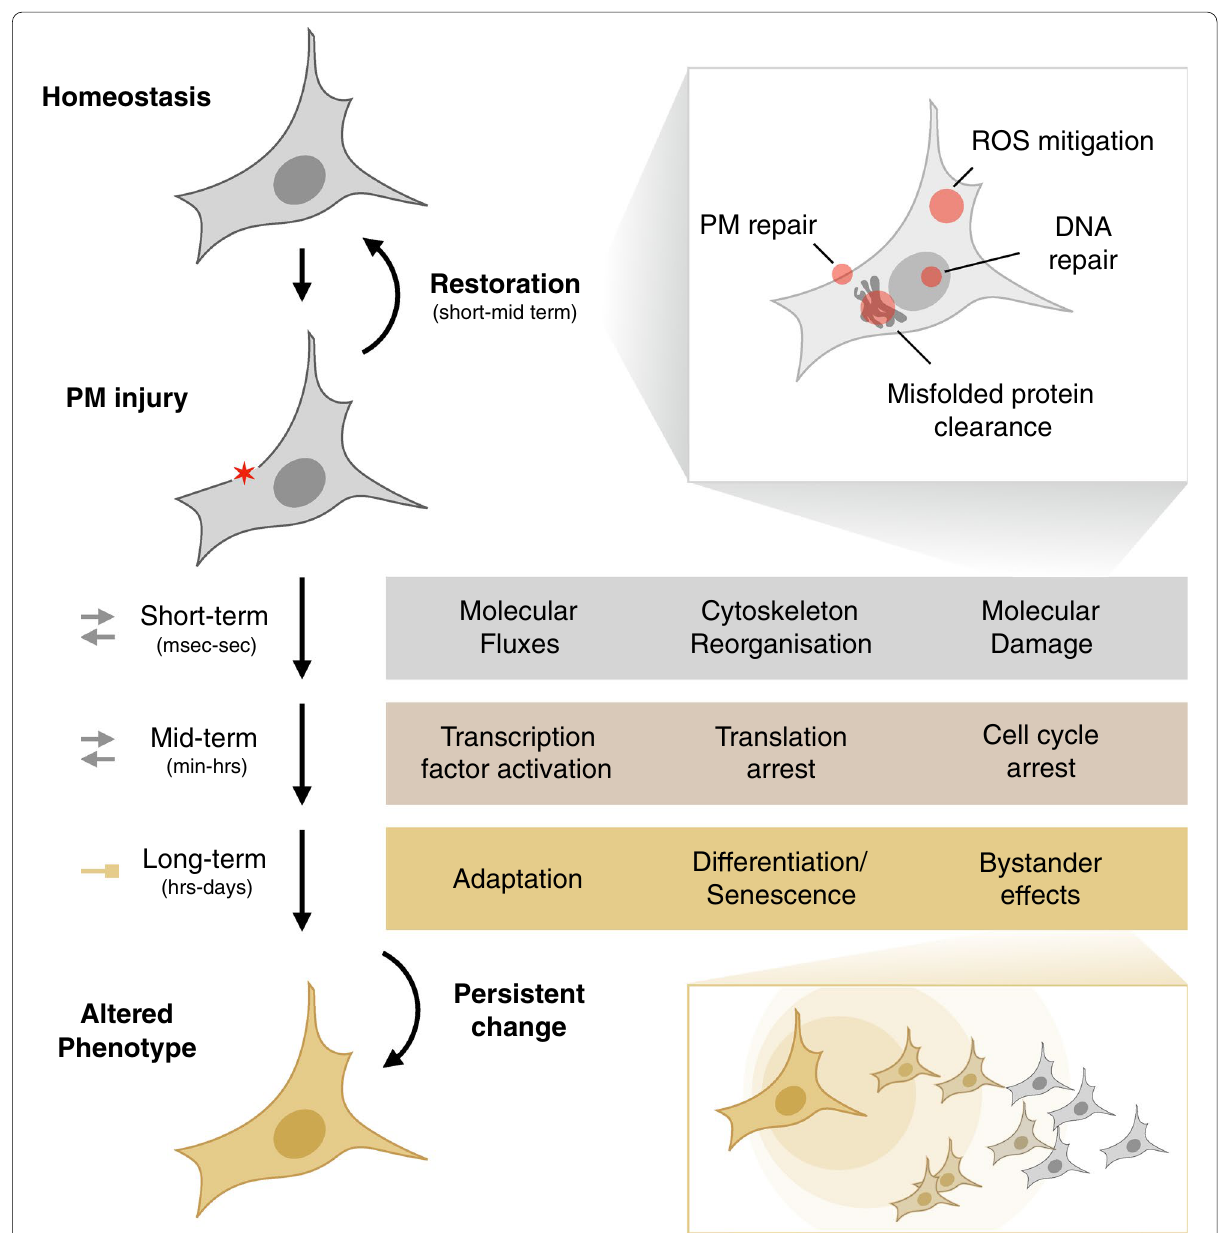
Fig. 3 Schematic overview of the different levels and aspects of the cellular response to PM injury. A detailed explanation of the responses can be found in the main